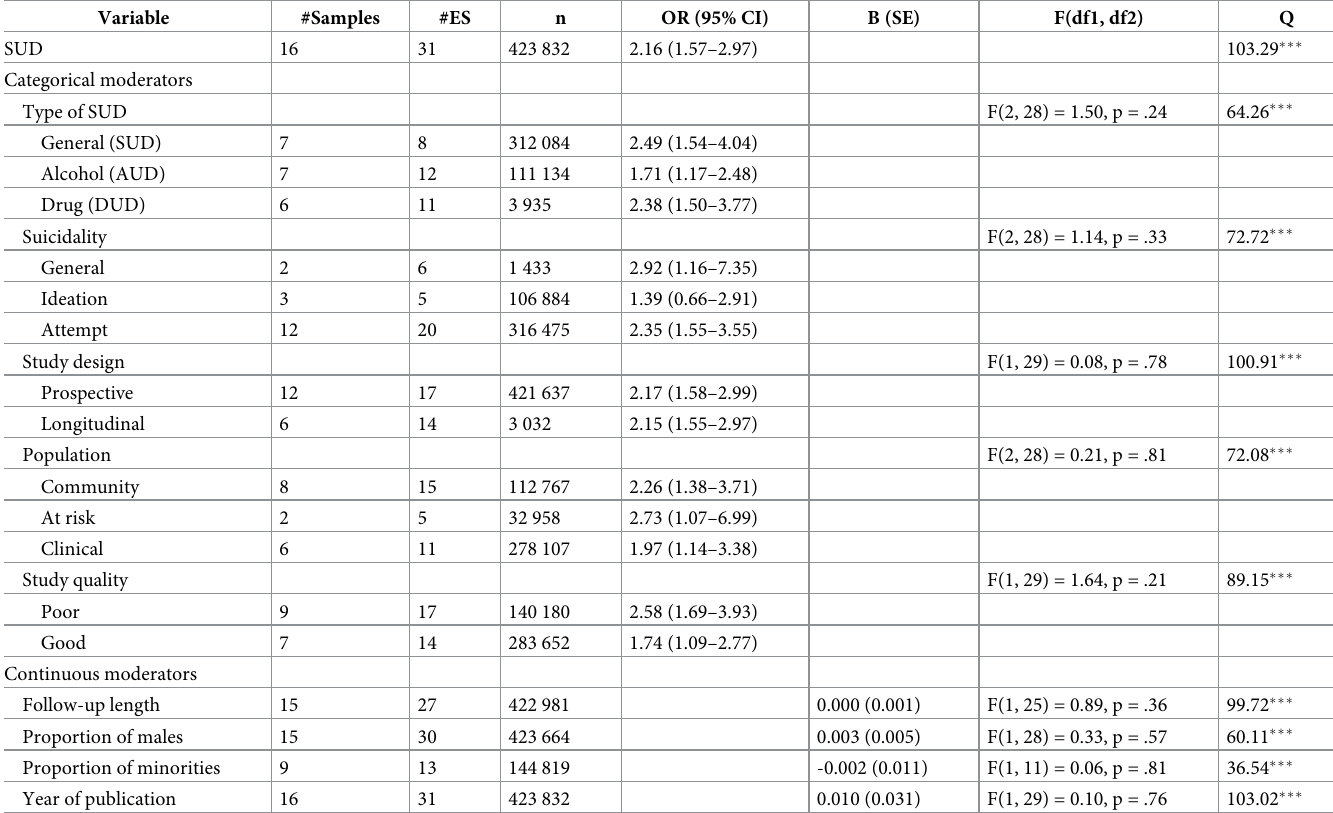
Table 2. Results of the three-level meta-analytic model for the secondary psychiatric disorder hypothesis